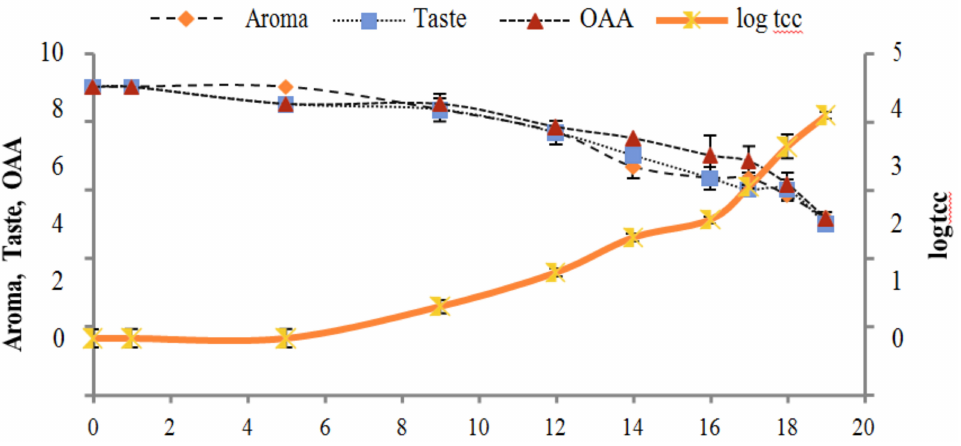
Figure 3. Relationship of total coliform count log cfu/mL growth trends with sensory scores of pasteurized milk for spoilage detection stored at 7 ◦ C.